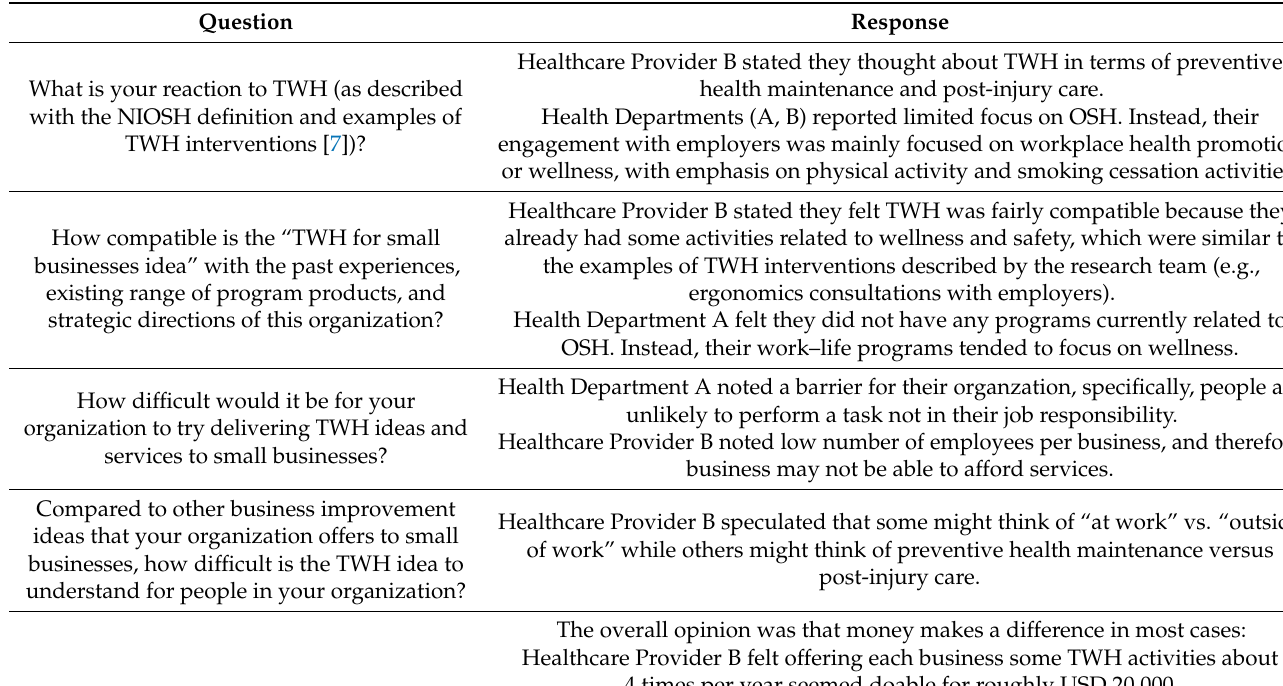
Table 2. Questions and representative responses with intermediary organization